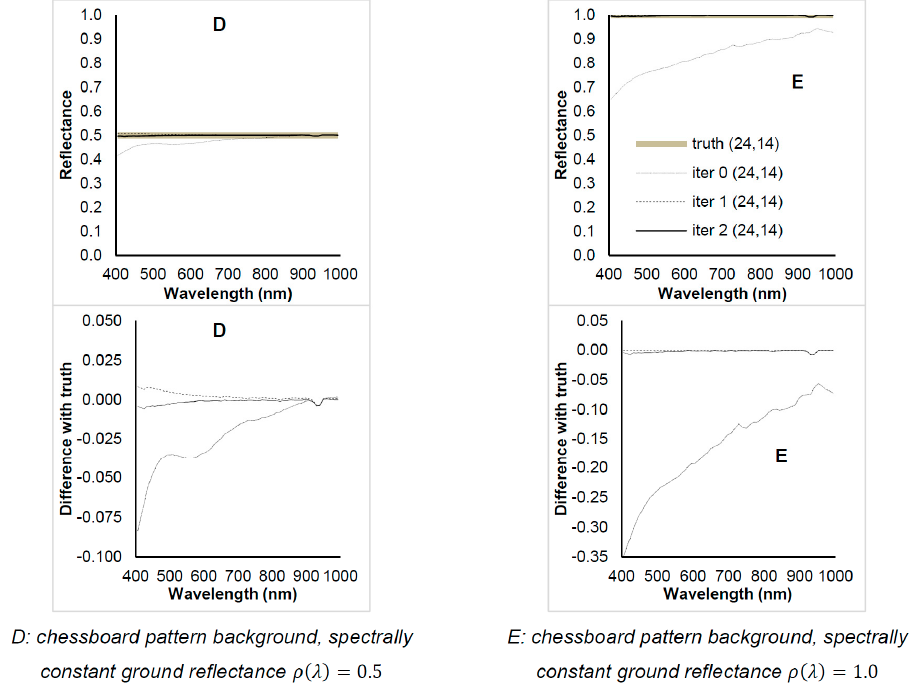
Figure 5. Reflectance spectra of the pixels D and E as the number of iterations increases. The pattern of surrounding pixels affects the first retrieval (iteration 0). Both the reflectance spectra (at the top ) and their difference with the ground truth (at the bottom ) are shown.